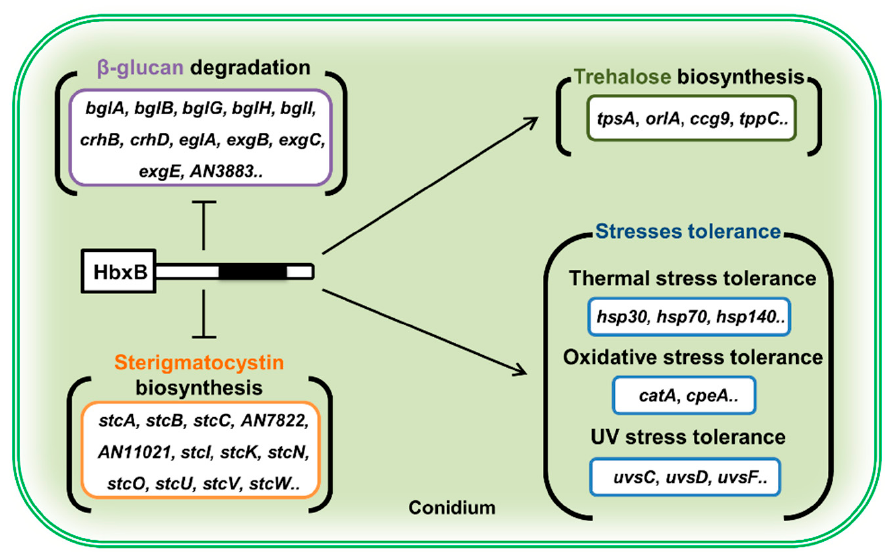
Figure 5. Proposed model depicting the role of HbxB in conidium (see the Discussion section). Supplementary Materials: The following are available online at www.mdpi.com/xxx/s1: Figure S1. Heat map images of DEGs between control and Δ hbxB conidia (fold change > 2.0; q < 0.05).